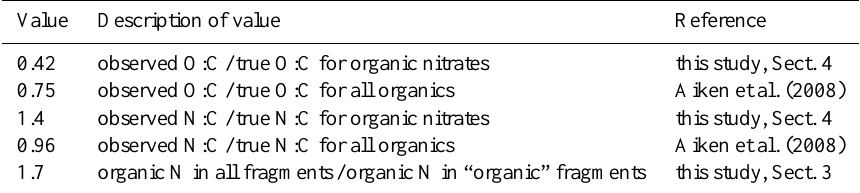
Table 4. A summary of the conversion factors used in deriving Eq. (1). .